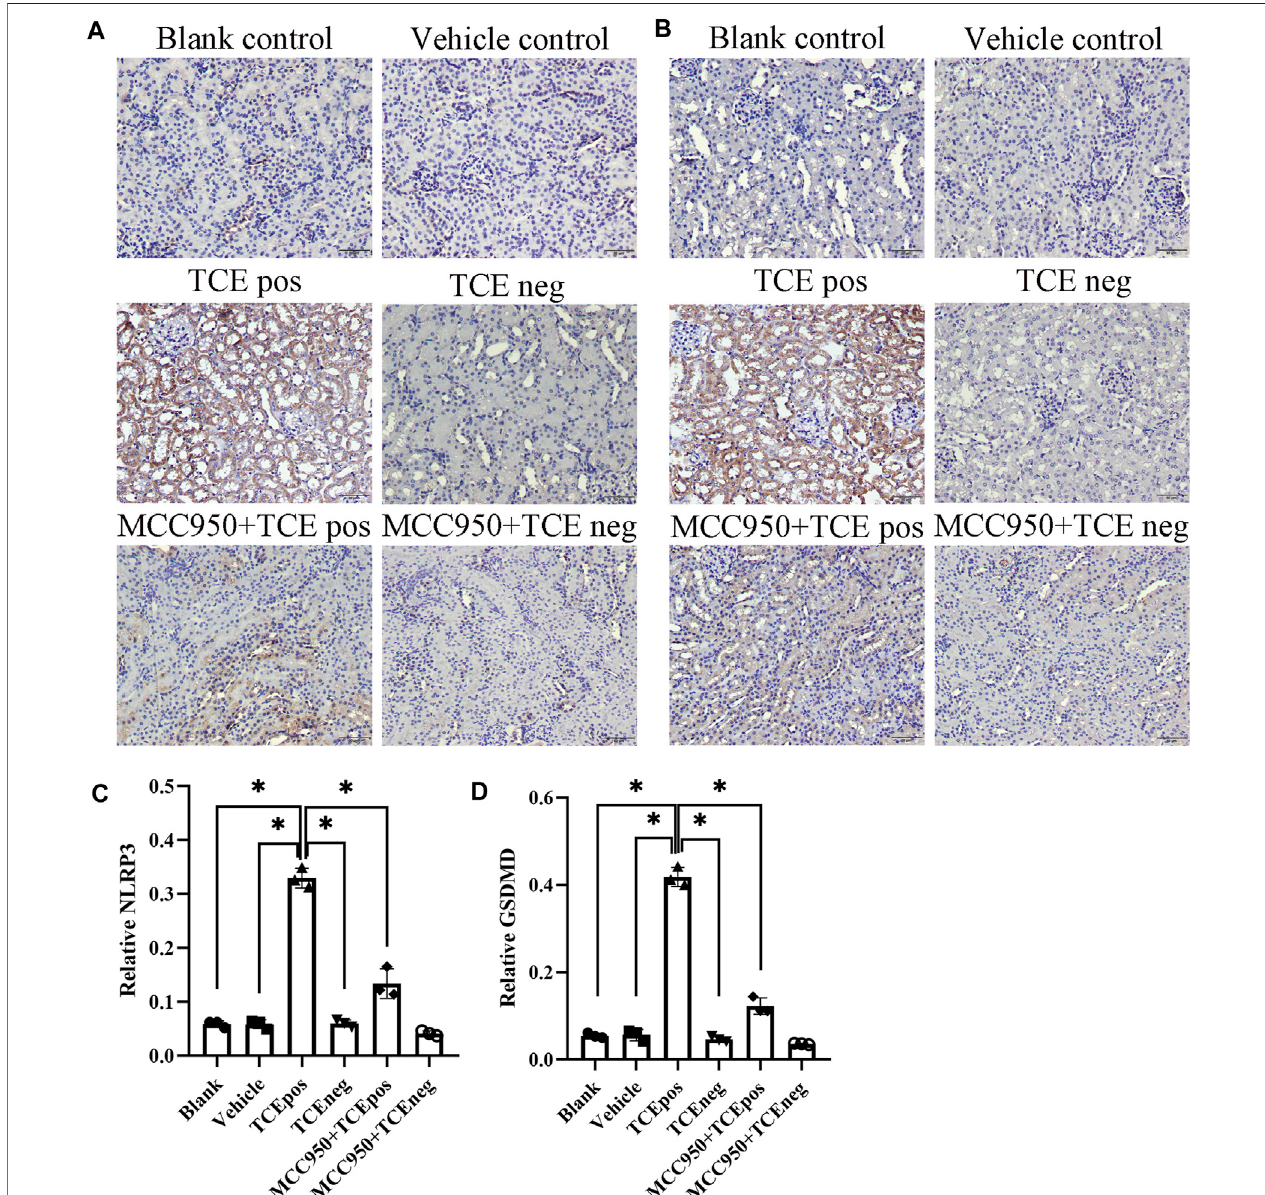
FIGURE 5 | MCC950 pretreatment attenuated the expression of GSDMD in mouse kidney. Expression of NLRP3 (A) and GSDMD (B) in mouse kidney tissue. (C,D) RelativeexpressionofNLRP3 (C) andGSDMD (D) wasassessedbytheaverageopticaldensityvalueinImageJ.Allthescalebarsrepresent50 μ m.Dataarerepresentative of three independent experiments and are expressed as the mean ± SD. n = 3 – 5/group. Levels of signi fi cance were de fi ned as below: * p < 0.05.